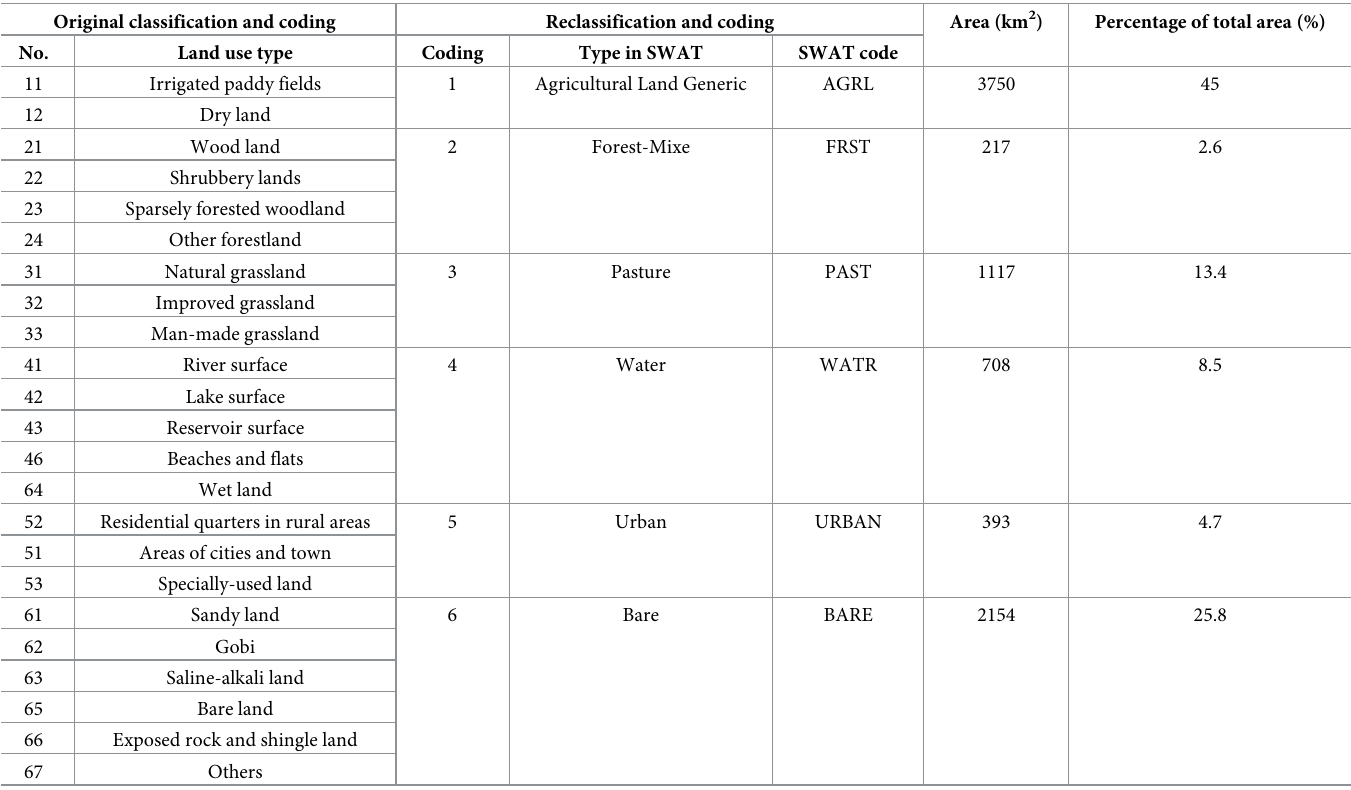
Table 1. Reclassification code conversion of land use types. Original classification and